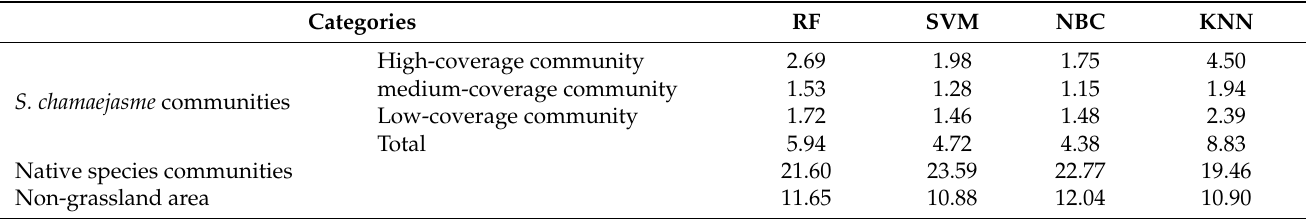
Table 5. S. chamaejasme distribution area estimated using the four algorithms (1 × 10 4